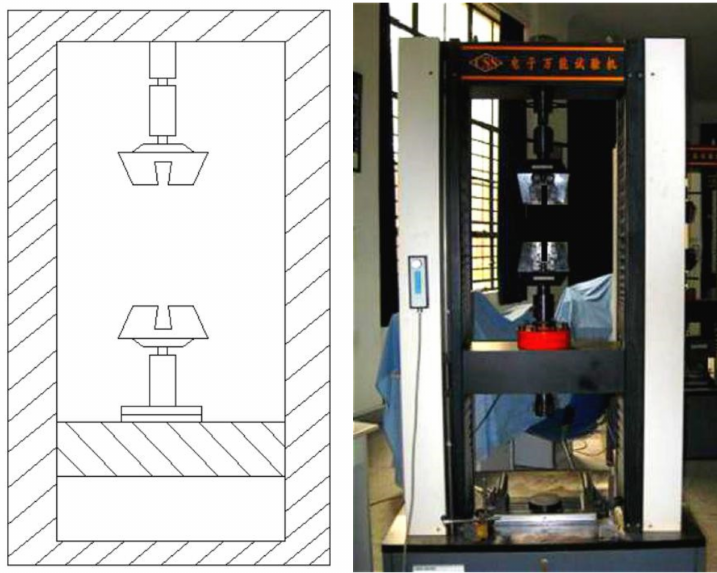
Figure 7. 300-kN CSS44100 electronic universal testing